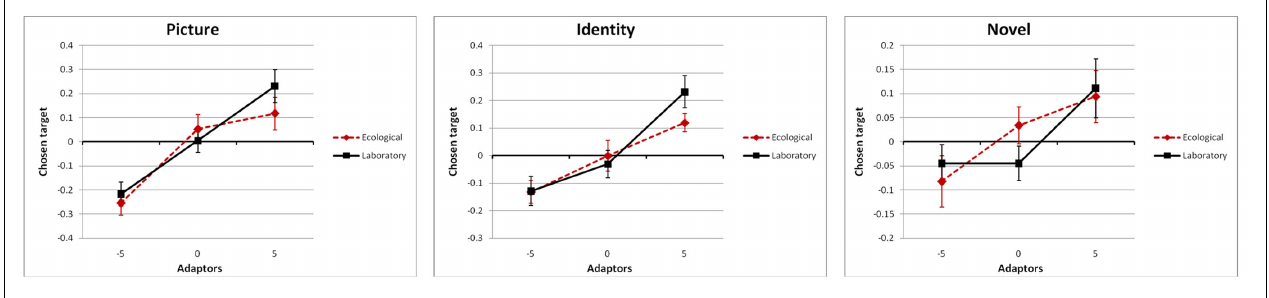
persons), and novel (depictions of different persons), split by the episodic compatibility conditions ecological (red dotted line) and laboratory (black solid line)